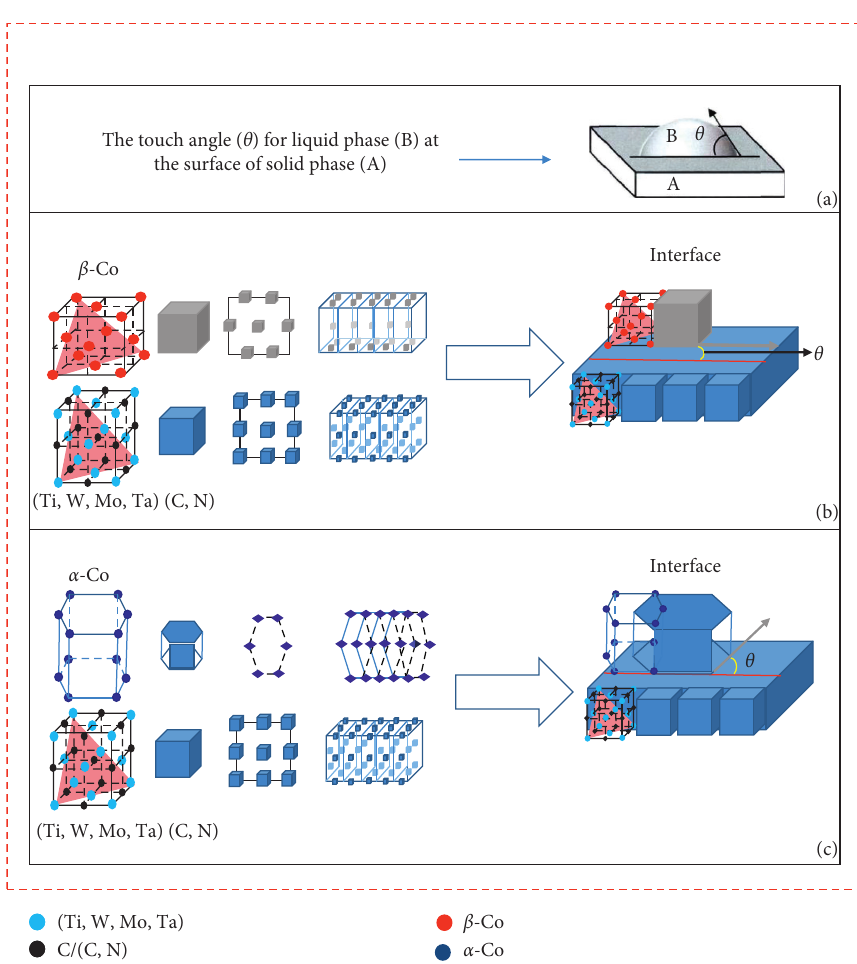
Figure 13: (a) Touch angle, (b) rim/binder face of sample C, and (c) the rim/binder face of sample